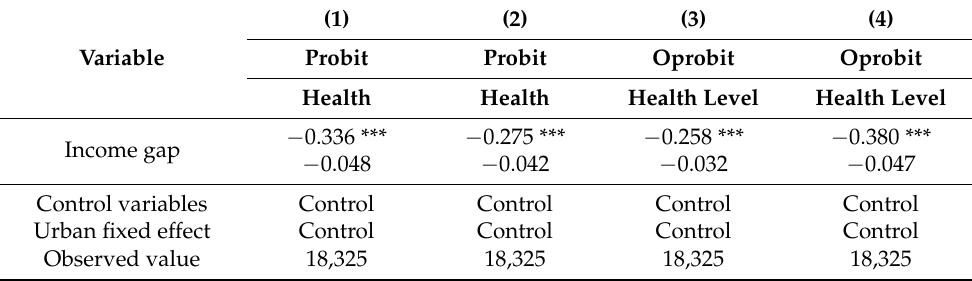
Table 5. Impact of different income gap indicators on health level of rural residents (Measured by Income).